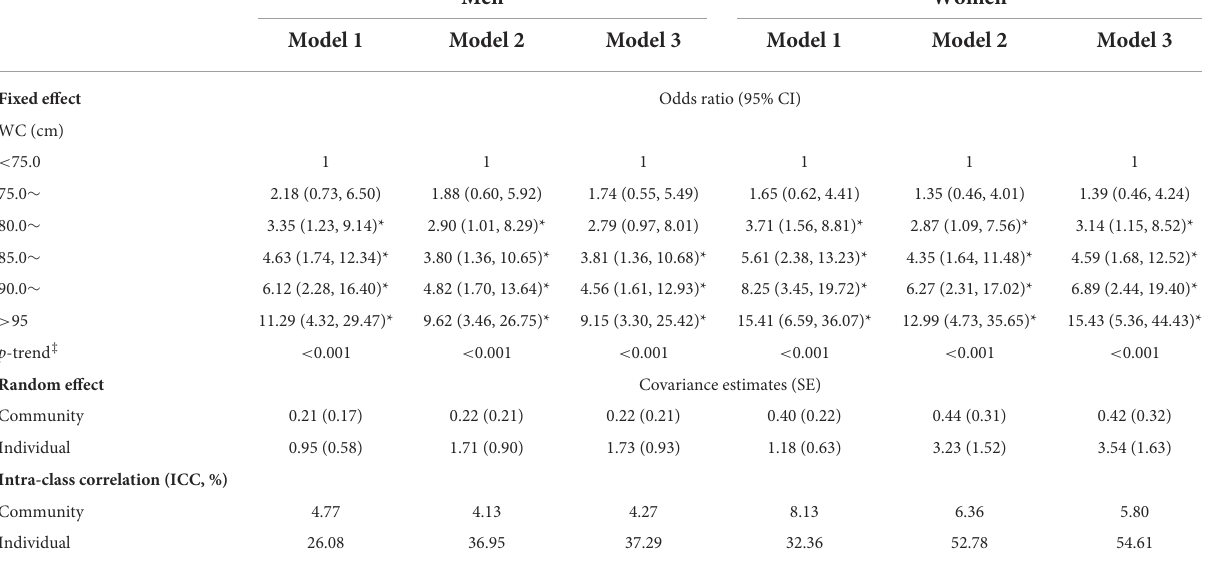
TABLE 3 Association between WC levels and risk of type 2 diabetes among Chinese adults aged 18–65, in three-level mixed-effects logistic regression † .